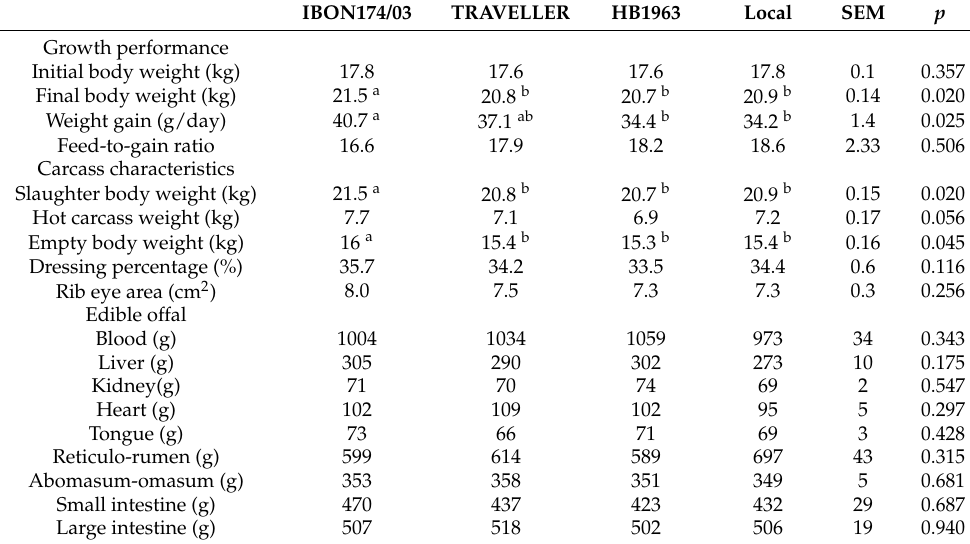
Table 4. Body weight change and carcass characteristics of Horro lambs fed diets containing straw from different varieties of barley supplemented with a concentrate